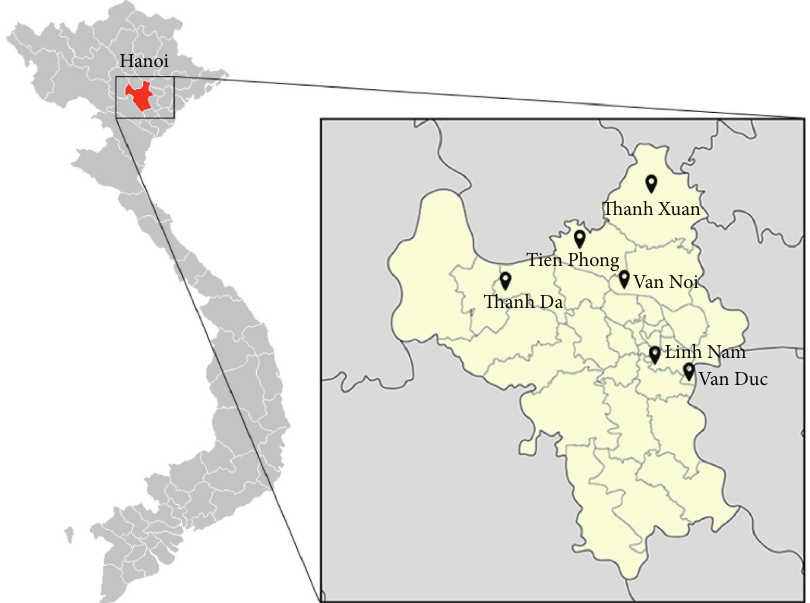
Figure 1: The geographical locations of the pakchoi cultivation